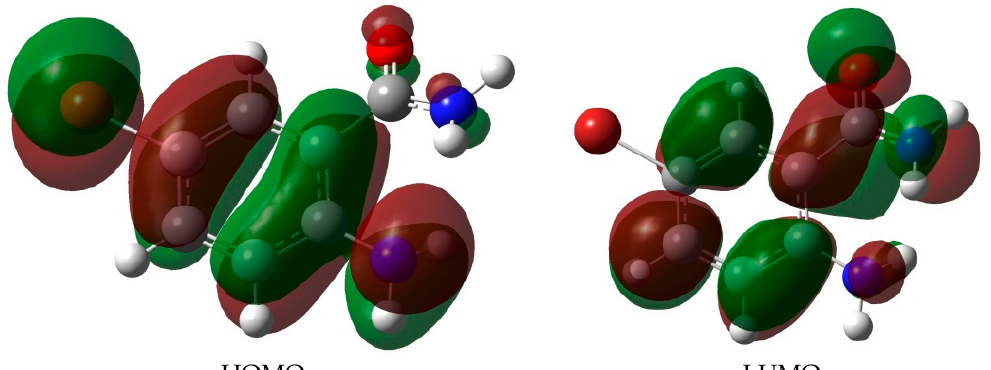
HOMO LUMO HOMO LUMO Figure 5. The HOMO and LUMO surfaces of ABB in DMSO. HOMO LUMO Figure 5. The HOMO and LUMO surfaces of ABB in DMSO. Figure 5. The HOMO and LUMO surfaces of ABB in Figure 5. The HOMO and LUMO surfaces of ABB in DMSO.